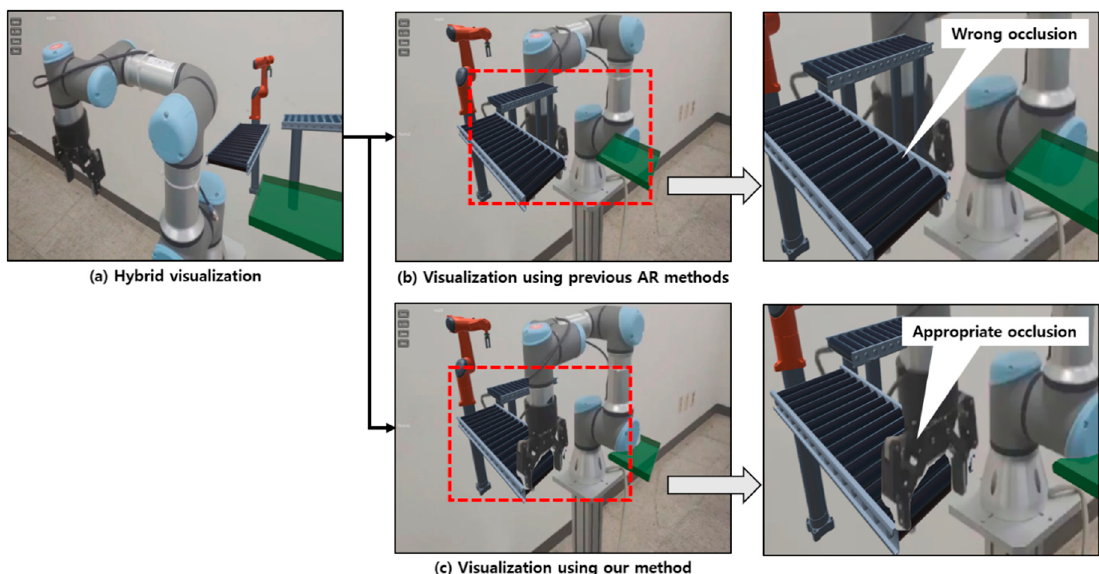
Figure 15. Dynamic modeling of a manufacturing layout using the proposed industrial AR.